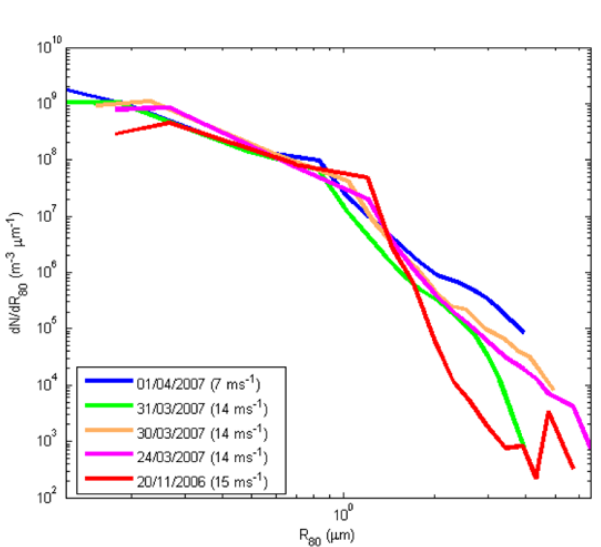
Fig. 3. The mean aerosol concentration spectra for each of the buoy deployments. The deployments are ordered by increasing wind speed, and the same colour scheme, identifying different days, is used throughout all subsequent